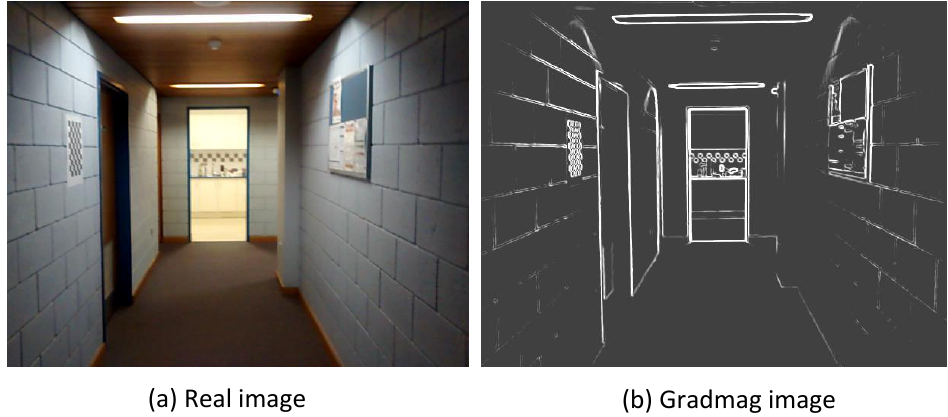
Figure 3. ( a ) A real sample image and ( b ) the corresponding gradient magnitude (gradmag) image after thresholding weak